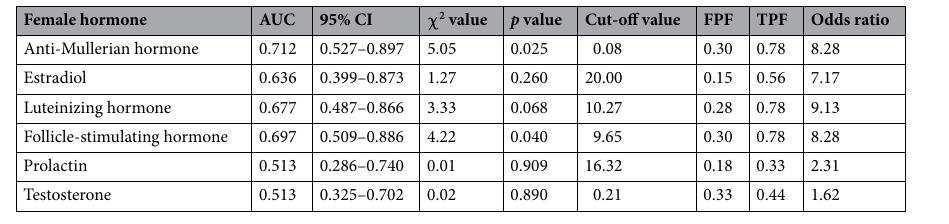
Table 2. ROC analysis of female hormones for early knee osteoarthritis. ROC: AUC: area under the curve, 95% CI: 95% confidence interval, FPF False positive fraction, TPF True positive fraction.